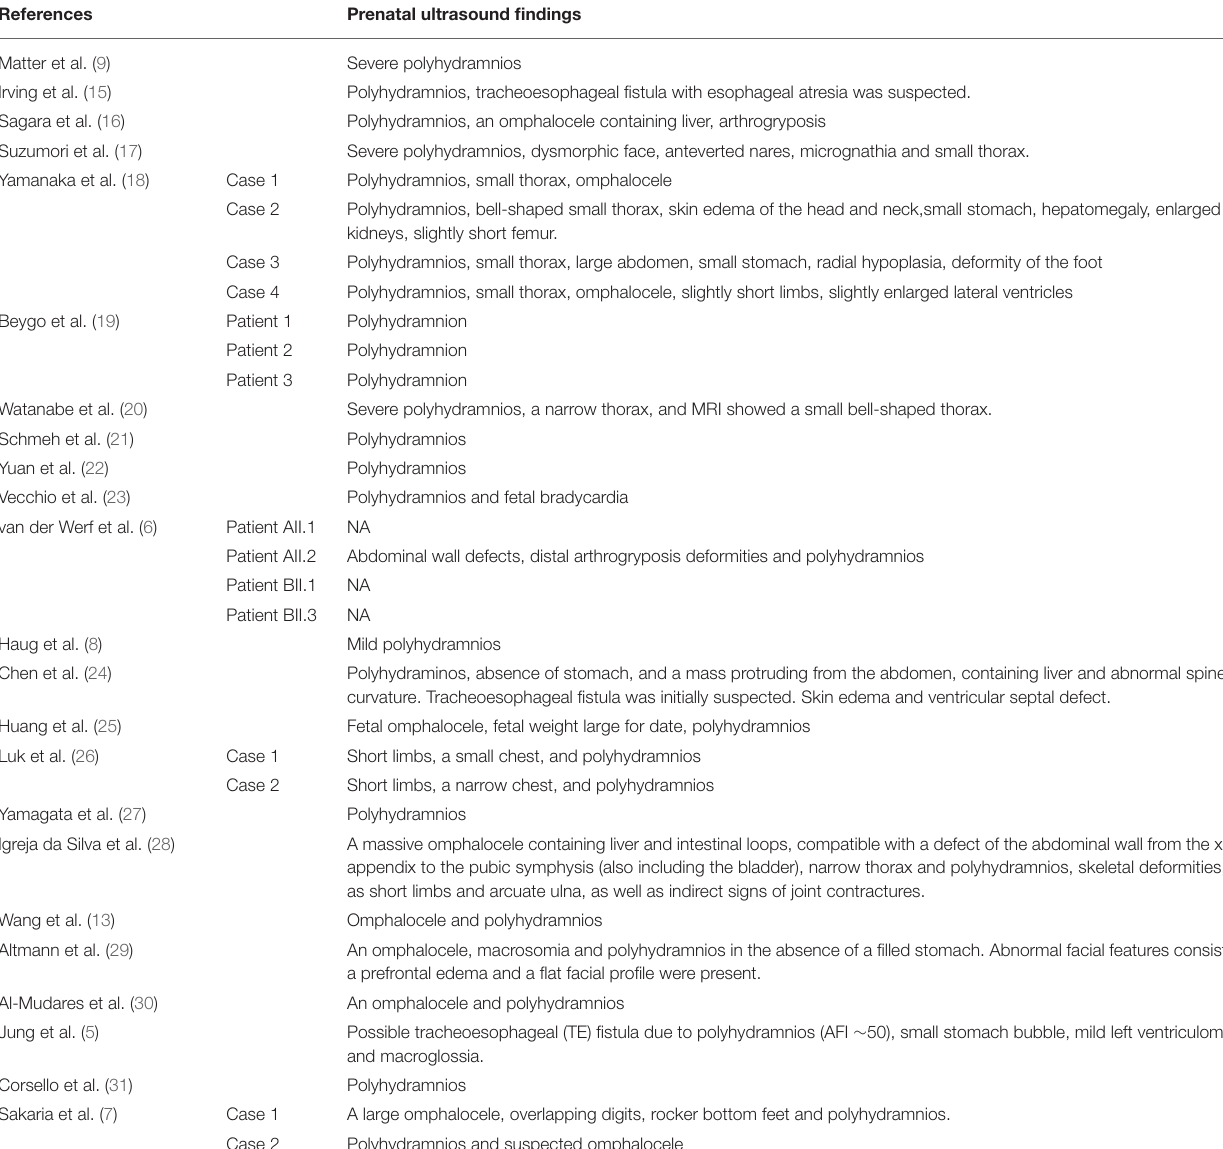
TABLE 2 | Summary of prenatal ultrasound findings on previously reported cases of Kagami–Ogata syndrome (KOS) after